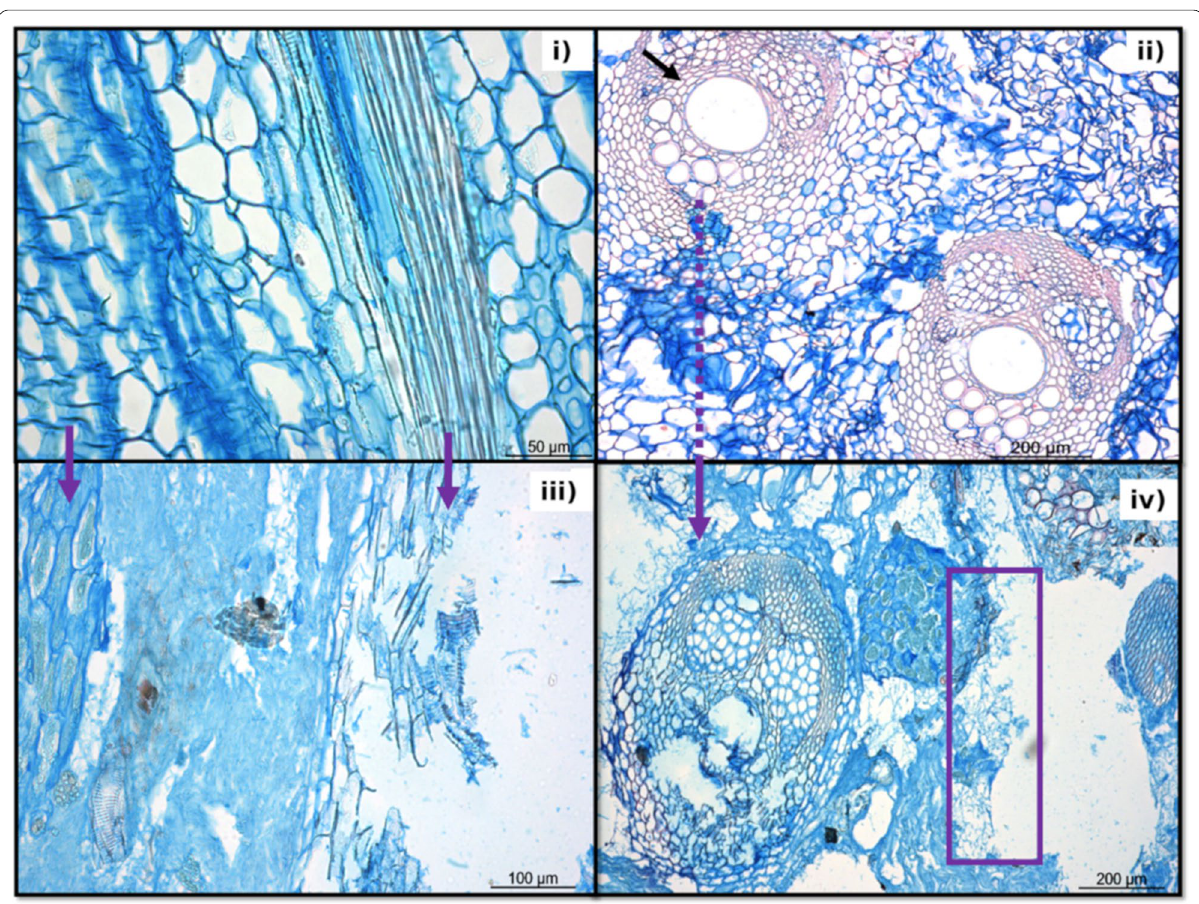
Fig. 5 Histological sections of peach palm sheaths (i) side 400 and (ii) cross-section 100. Cold-pressed mycelium-based composite side (iii) × × 200 and (iv) cross-section 100. The arrows indicate the degradation within the same region after the composite × ×